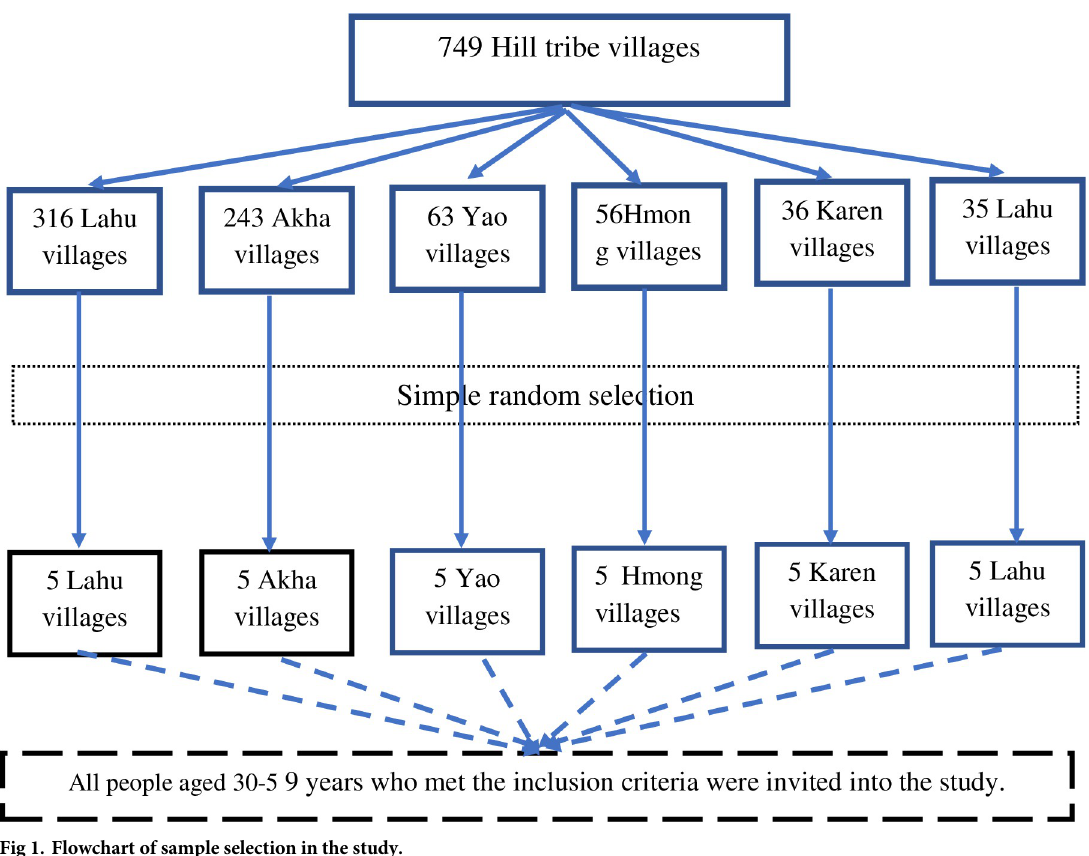
Fig 1. Flowchart of sample selection in the